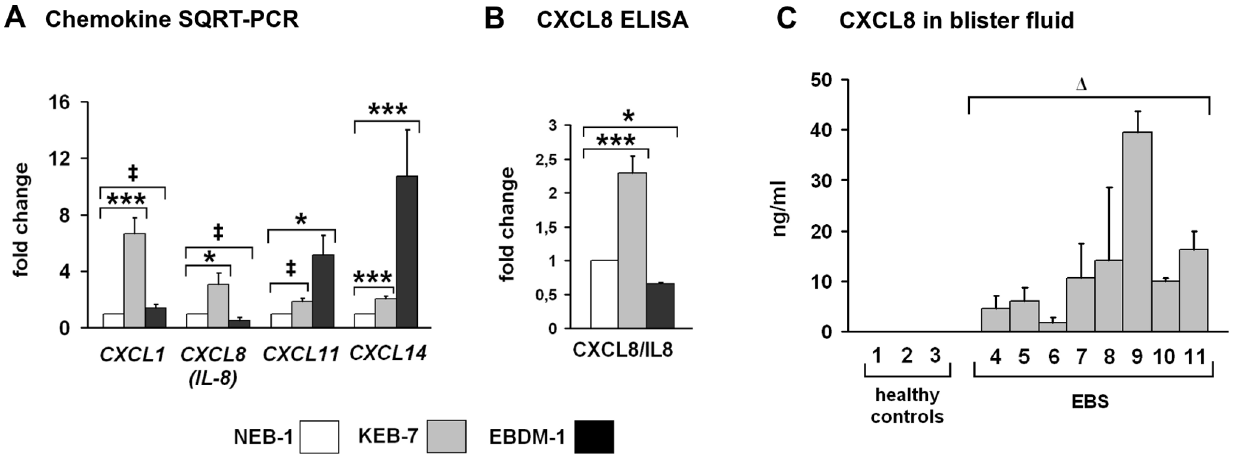
Figure 6. Expression of chemokines. A. SQRT-PCR of chemokine mRNA expression in NEB-1, KEB-7 and EBDM-1 (n=3 to n=5). CXCL1 , CXCL8/IL-8 and CXCL14 expression was increased in KEB-7. Only CXCL11 and CXCL14 were increased in EBDM-1. B. CXCL8/IL-8 ELISA of 48-h-conditioned cell culture supernatant showed 2-fold upregulation at the protein level in KEB-7 but not in EBDM-1, which correlates with the SQRT-PCR results (n=4). C. CXCL8/IL-8 concentrations were highly increased in EBS patients blister fluids. In blister fluids of healthy controls no CXCL8/IL-8 was detectable (n=3 to n=4). The numbers correlate with Table 1. Student’s t -test was performed with p values: * # 0.05, *** # 0.005, D # 0.001, ` =no significant difference between investigated cell lines. (In 6C, the Student’s t -test compared the entire patient group to the entire control group).